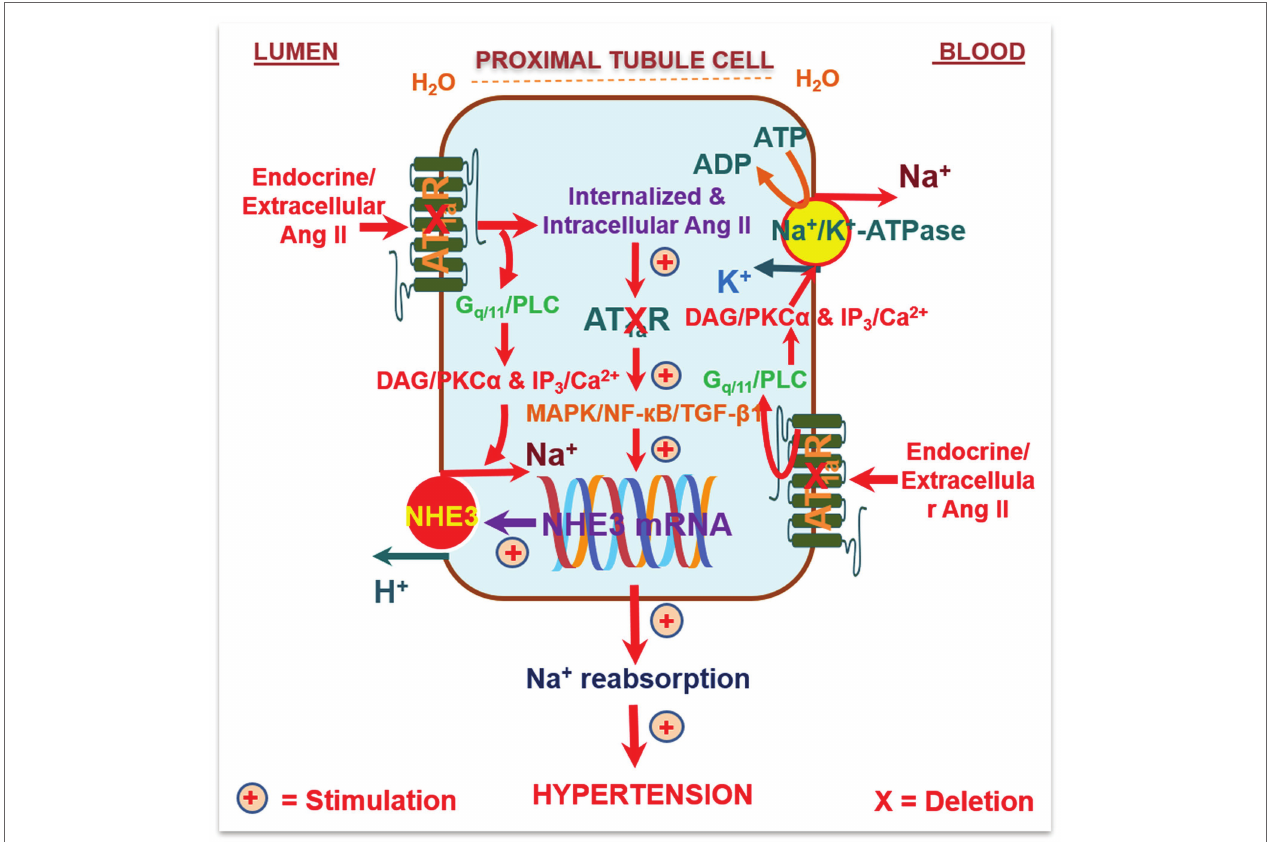
FIGURE 2 | Schematic diagram showing the hypothesis that circulating/extracellular Ang/intratubular II binds to apical (lumen) and basolateral membrane (blood) AT 1a receptors, and activates G protein-coupled Gq11/phospholipase C (PLC)/diacylglycerol(DAG)/protein kinase C α (PKC α ) signaling, and/or inositol trisphosphate (IP 3 )/Ca 2+ signaling pathways. This activated signaling increases the activities and expression of Na + /H + exchanger 3 (NHE3), Na + /K + -ATPase, and other Na + cotransporters in the proximal tubules to increase Na + reabsorption and maintain arterial blood pressure under physiological conditions and elevate it during Ang II-induced hypertension. Alternatively, circulating/extracellular Ang II is taken up by the proximal tubules via AT 1a receptors and the endocytic receptor protein megalin under physiological conditions and during Ang II-induced hypertension to act as an intracellular/intracrine peptide. The latter will in turn induce long-term transcriptional effects to increase the expression of NHE3, Na + /K + -ATPase, and other Na + cotransporters in the proximal tubules, promote proximal tubule Na + reabsorption, and elevate blood pressure. As expected, deletion of AT 1a receptors selectively in the proximal tubules of the kidney will attenuate circulating/ extracellular and intratubular/intracellular Ang II-induced hypertension in PT- Agtr1a − / − mice. Reproduced with permission (Li et al.,